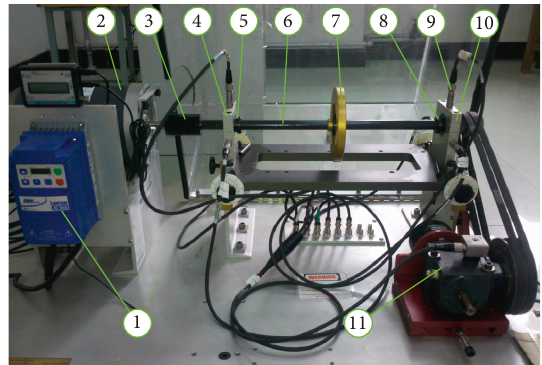
Figure 3: Machinery fault simulator: 1, frequency converter; 2, motor; 3, coupling; 4, inboard bearing seat; 5, normal bearing; 6, shaft; 7, rotor disc; 8, testing bearing; 9, acceleration sensor; 10, outboard bearing seat; 11,